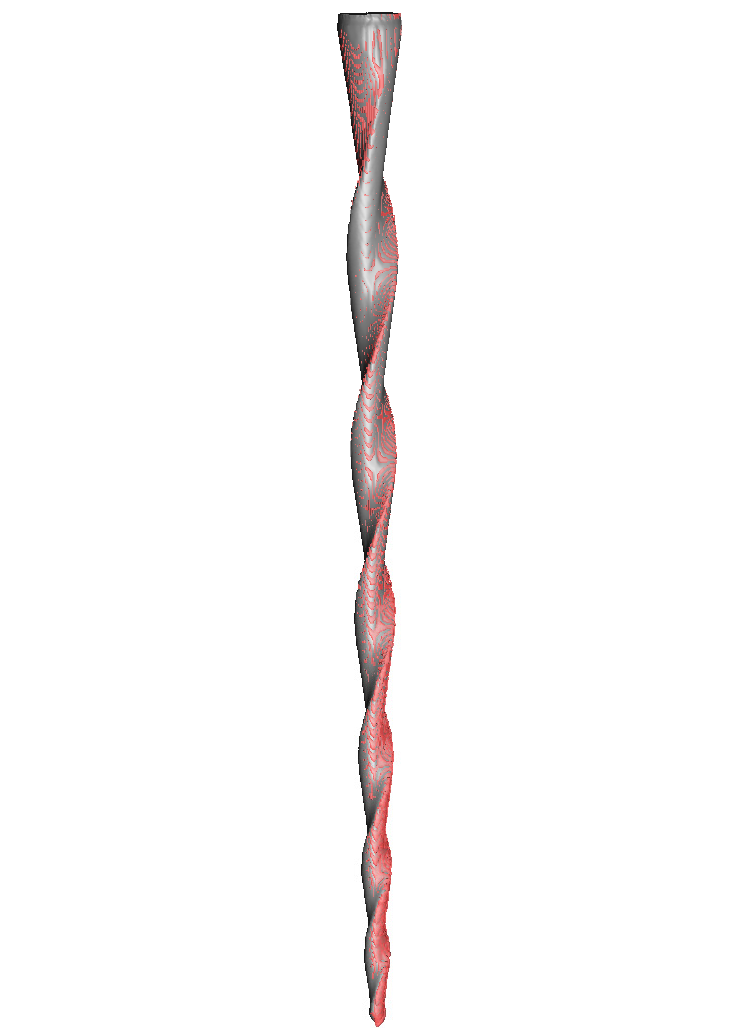
Figure 2. The procedure for alignment between the preoperative (red) and postoperative (grey) digital files and identification of the localization of the CM-wire NiTi alloy endodontic reciprocating files.